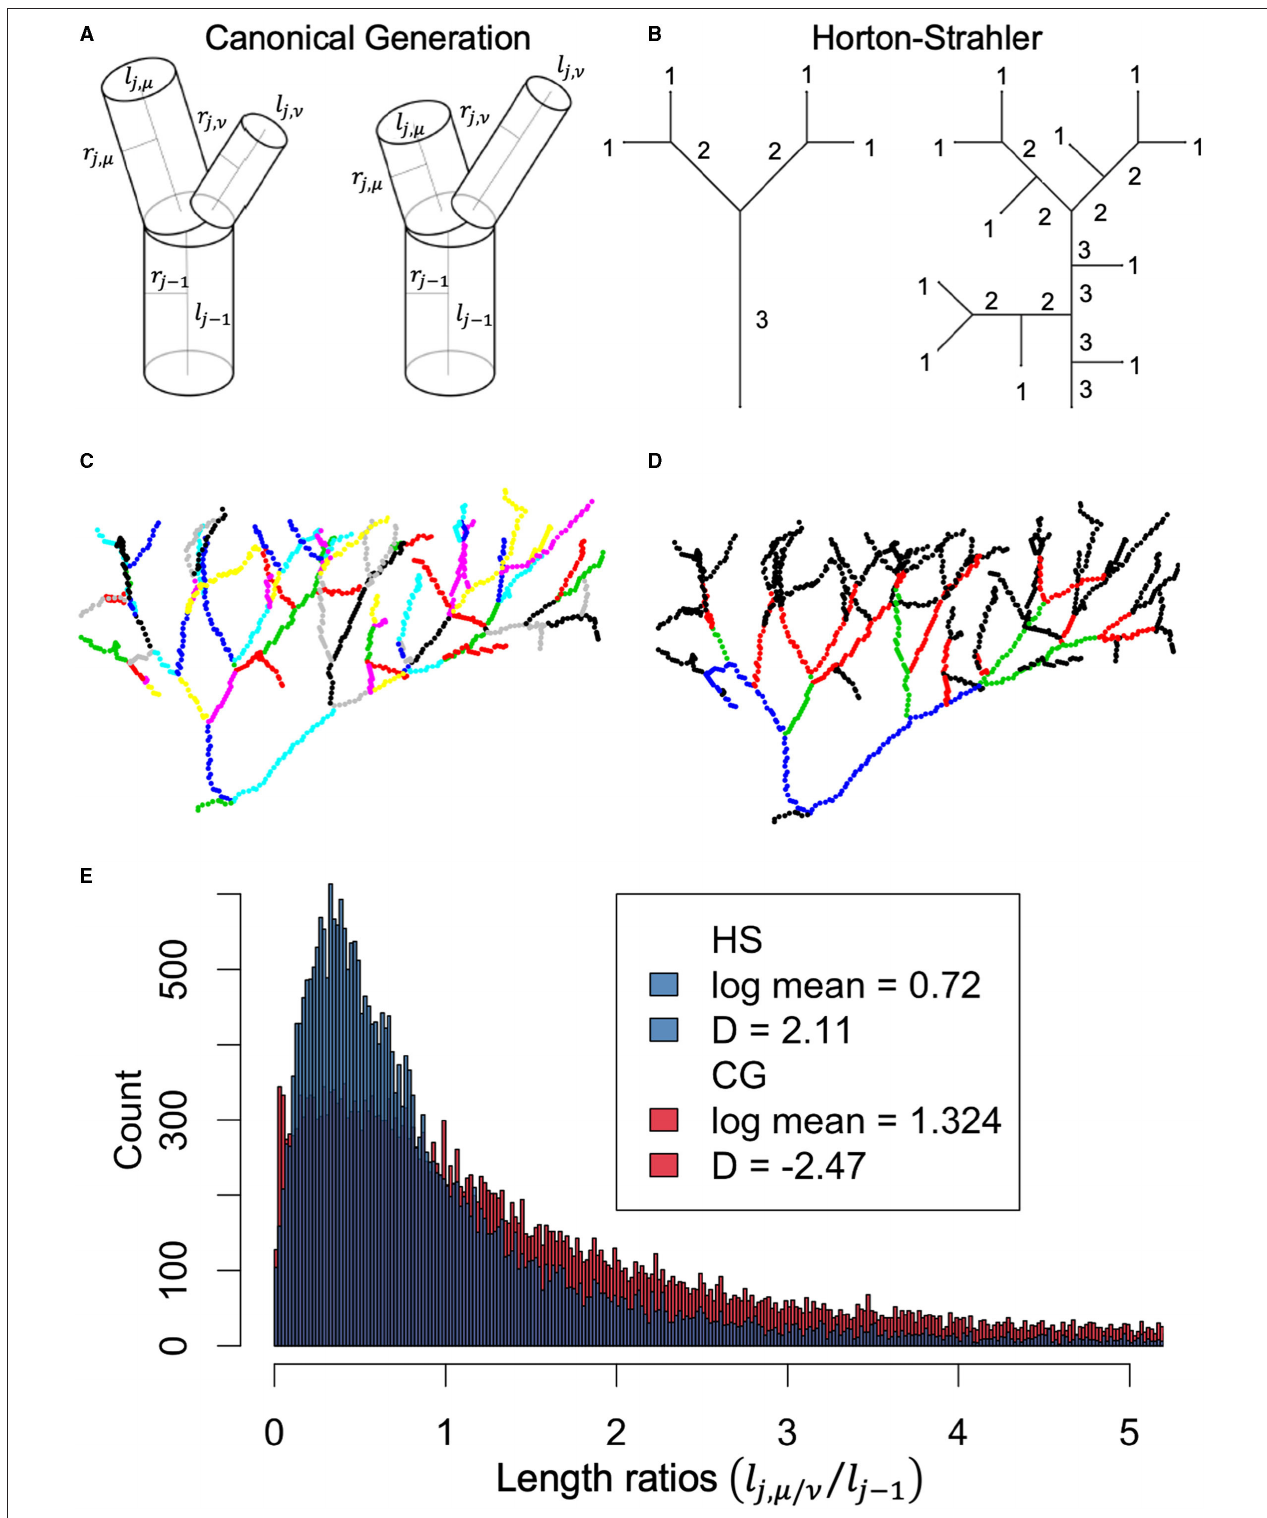
FIGURE 4 | (A) Canonical generation (CG) labeling for asymmetric bifurcation demonstrates how vessel endpoints are determined by presence of bifurcation. (B) Horton-Strahler (HS) labeling demonstrating how vessel endpoints are determined by changes in HS label. (C) Example vessel network color coded by different